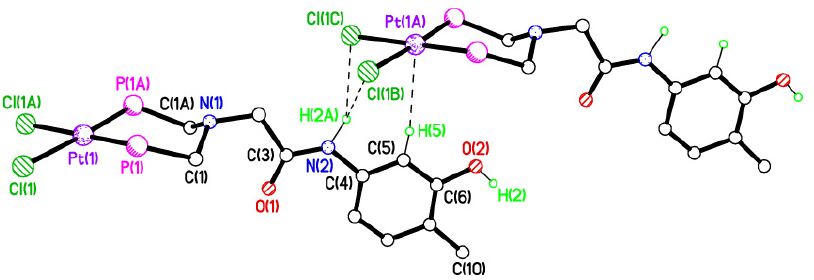
Figure 13. Packing plot of 5d · Et 2 O. Most H atoms, two Ph groups per P atom, and a diordered Et 2 O molecule modelled by the Platon Squeeze procedure, are omitted for clarity. Symmetry operators: